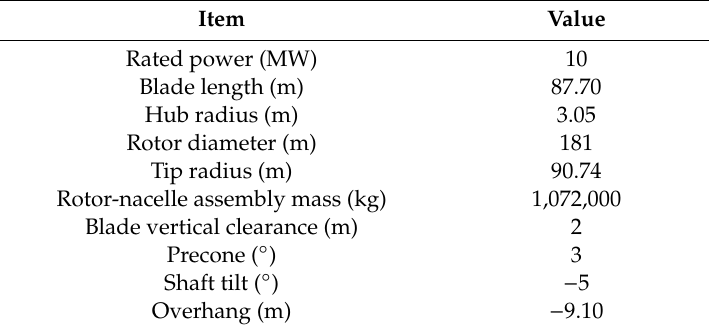
Table 2. Main properties of the baseline 10-MW OWT model [5].